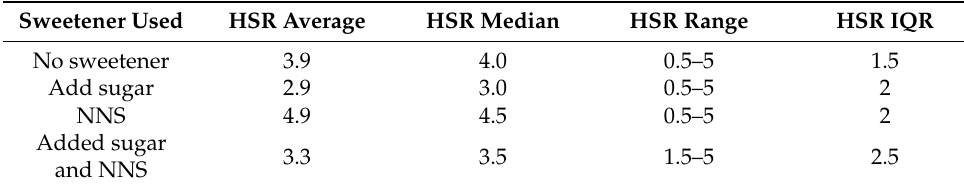
Table 3. Frequency and proportion of sweeteners used in new products that displayed a HSR